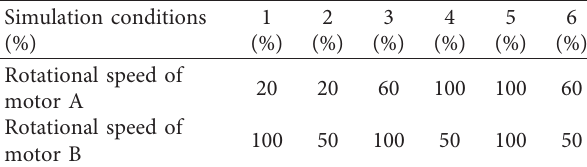
Table 4: Operating conditions.